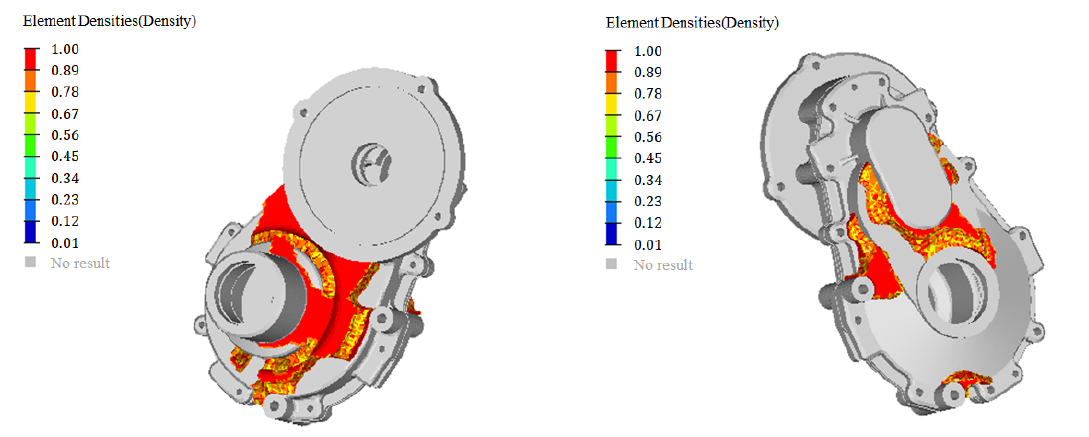
Figure 17. Result of topology optimization.